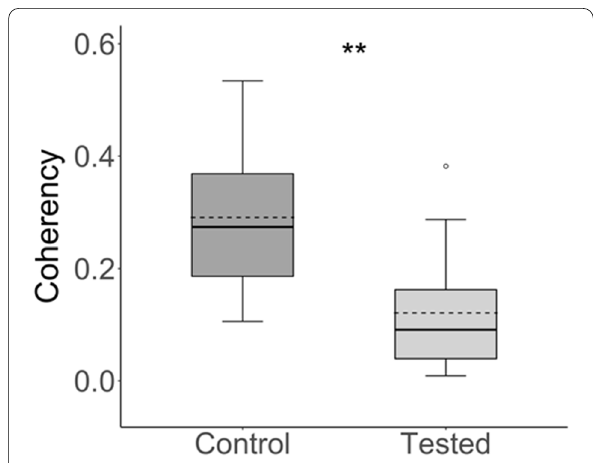
Fig. 4 Coherency coefficient of control and fatigue loaded ACL fibers in SHG images from paired knee specimens (P1 ‑ P3). Loss of coherency in the tested ACLs (average coherency coefficient in dashed line: 0.12. 0.09) compared to control ACLs (average ± coherency coefficient in dashed line: 0.29 0.15) indicates a ± reduction of fiber alignment from fatigue loading ( P 0.003). (solid =